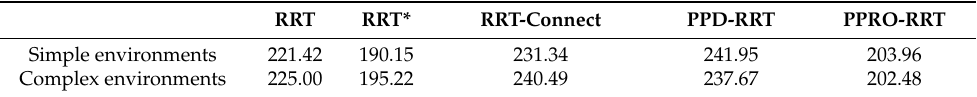
Table 4. The path length [23] of various algorithms in two kinds of experimental environments.